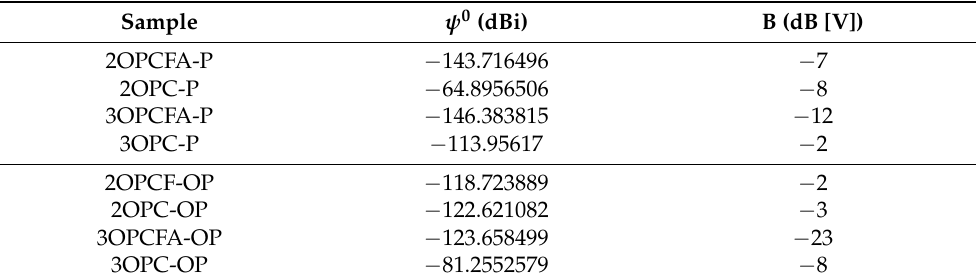
Figure 6. Power spectral density (PSD) for specimens subjected to Impressed current cathodic protection of reinforced concrete mixtures (OPC-P and OPCFA-P). ( a , b ) Potential, 2 and 3 months, ( c , d ) Current, 2 and 3 months. Table 7. Parameters obtained by PSD for reinforced concrete mixtures (OPC-P/OP and OPCFA-